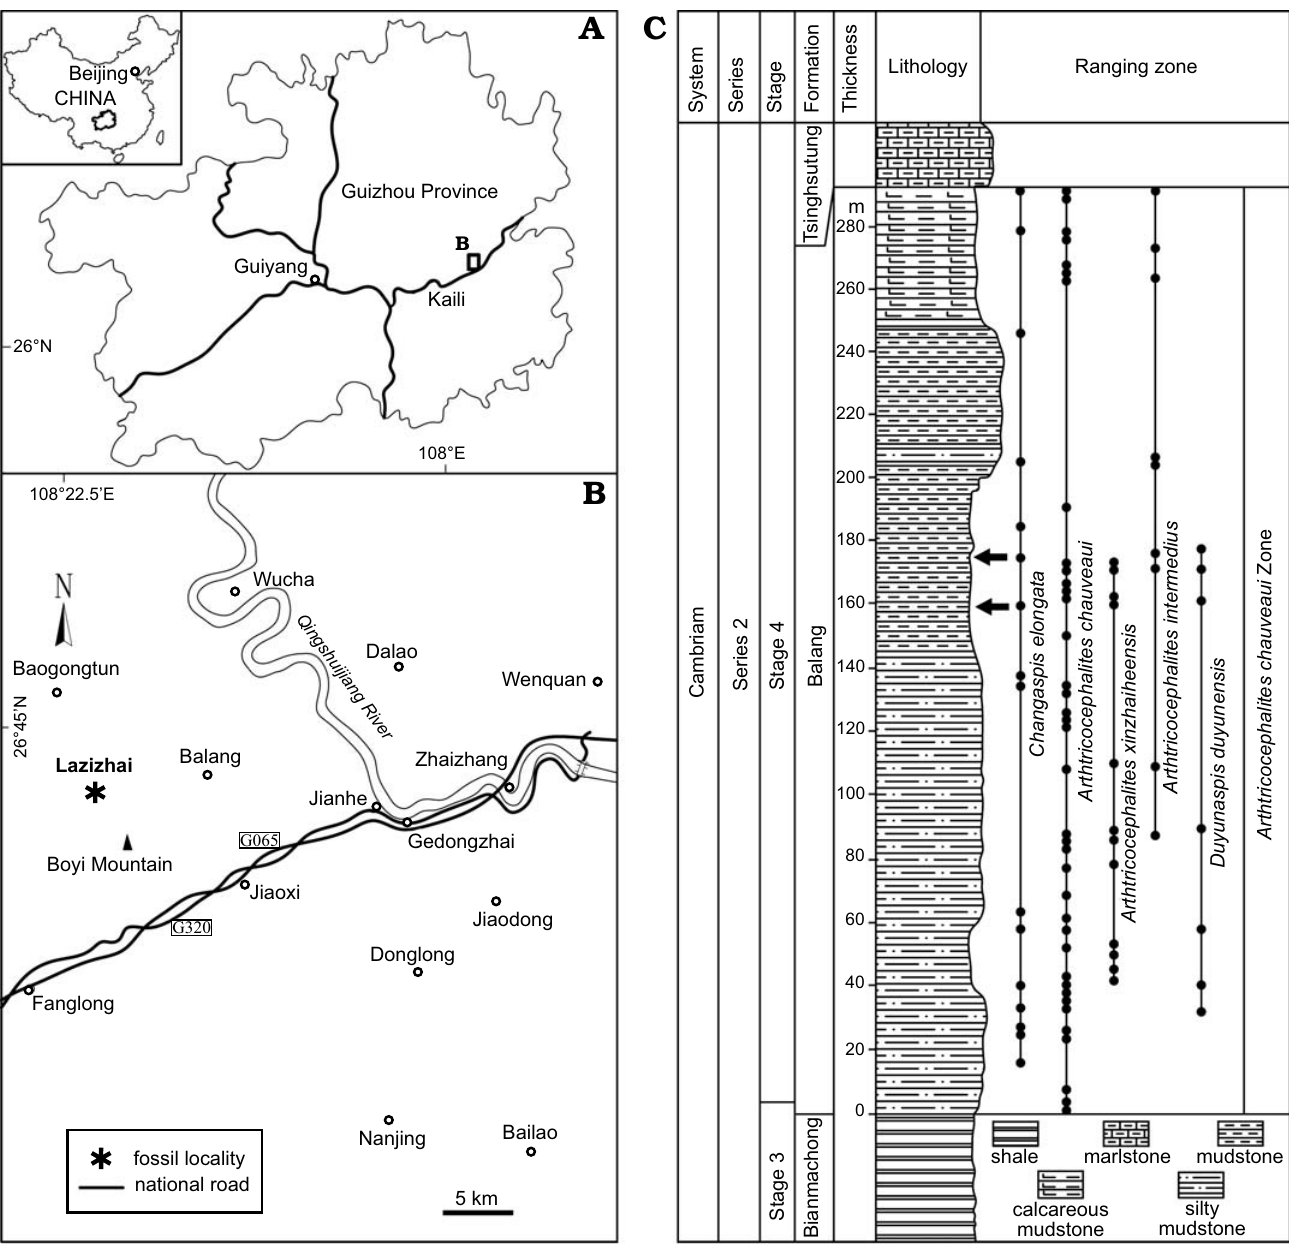
Fig. 1. A . Map showing the position of collecting localities in the Guizhou Province. B . Map of the fossil locality Lazizhai, 6.4 km from Jianhe, Guizhou Province, South China. C . Stratigraphical column of the Balang Formation (Cambrian Stage 4), showing the horizon where the material was collected (arrows), and the stratigraphic occurrences of oryctocephalid